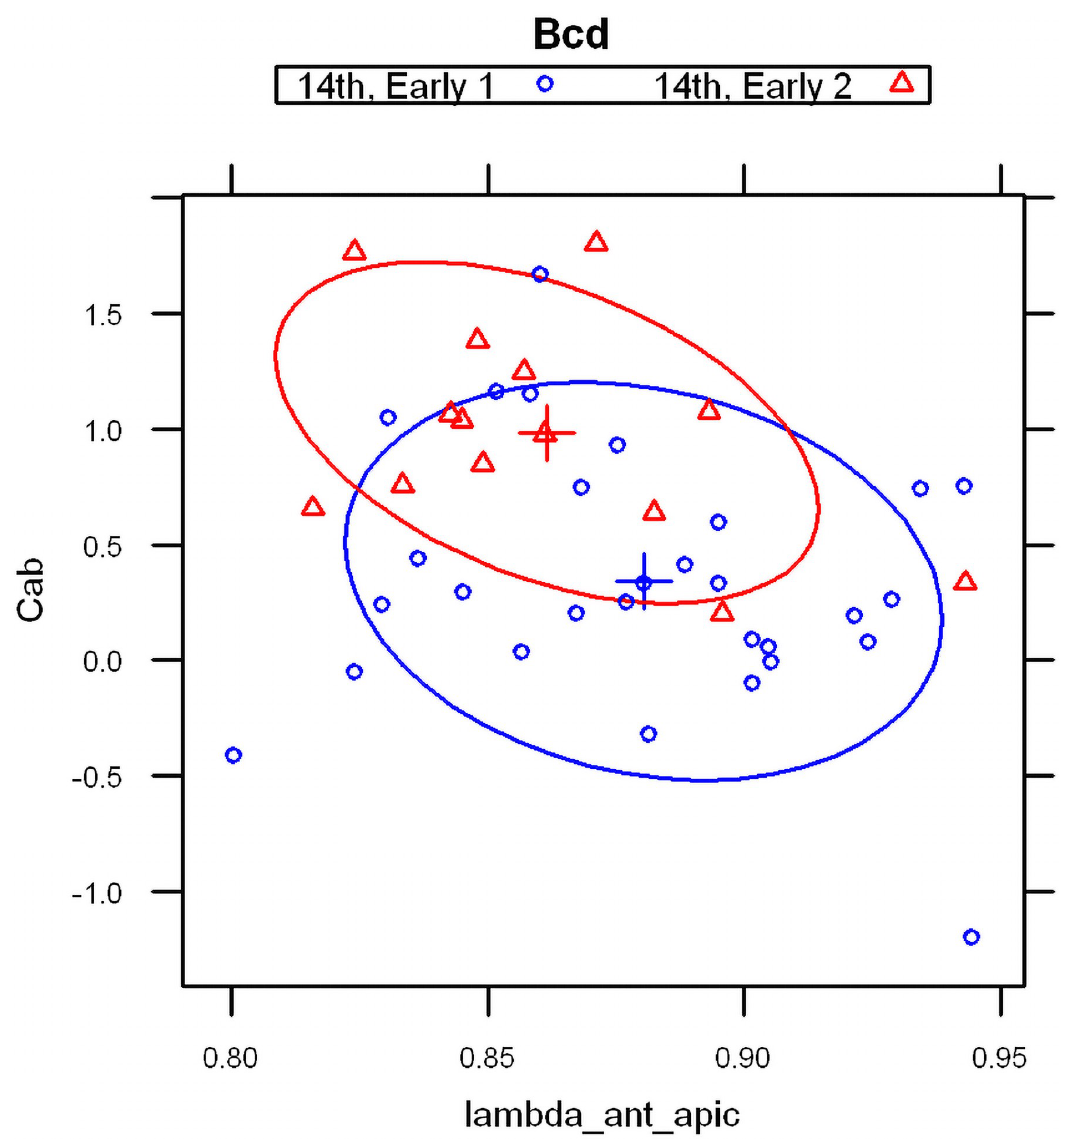
� � . Within several vs C ab ¼ In C apical ð Þ = C basal ð Þ anterior anterior anterior